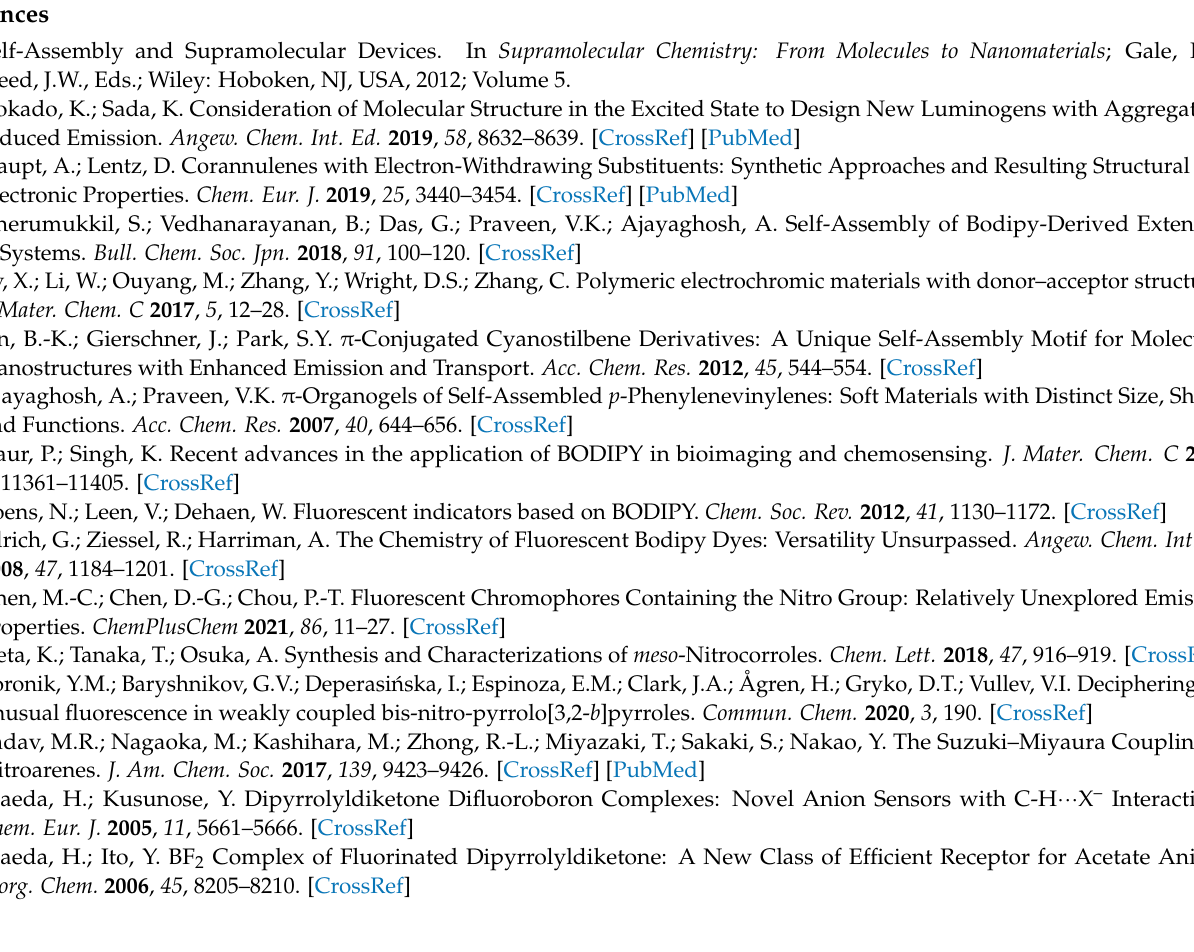
Supplementary Materials: FiguresS1–S3: 1 Hand 13 C{ 1 H}-NMRspectra,FiguresS4andS5: Ortep drawings of single-crystal X-ray structures, Figure S6: Optimized structures, Figure S7: Molecular orbitals (HOMO and LUMO), Figures S8–S10: Theoretical UV/vis absorption spectra, Figures S11 and S12: UV/vis absorption spectral changes and titration plots upon the addition of anions in CH 2 Cl 2 , Figure S13: 1 H-NMR spectral changes upon the addition of TBACl in CD 2 Cl 2